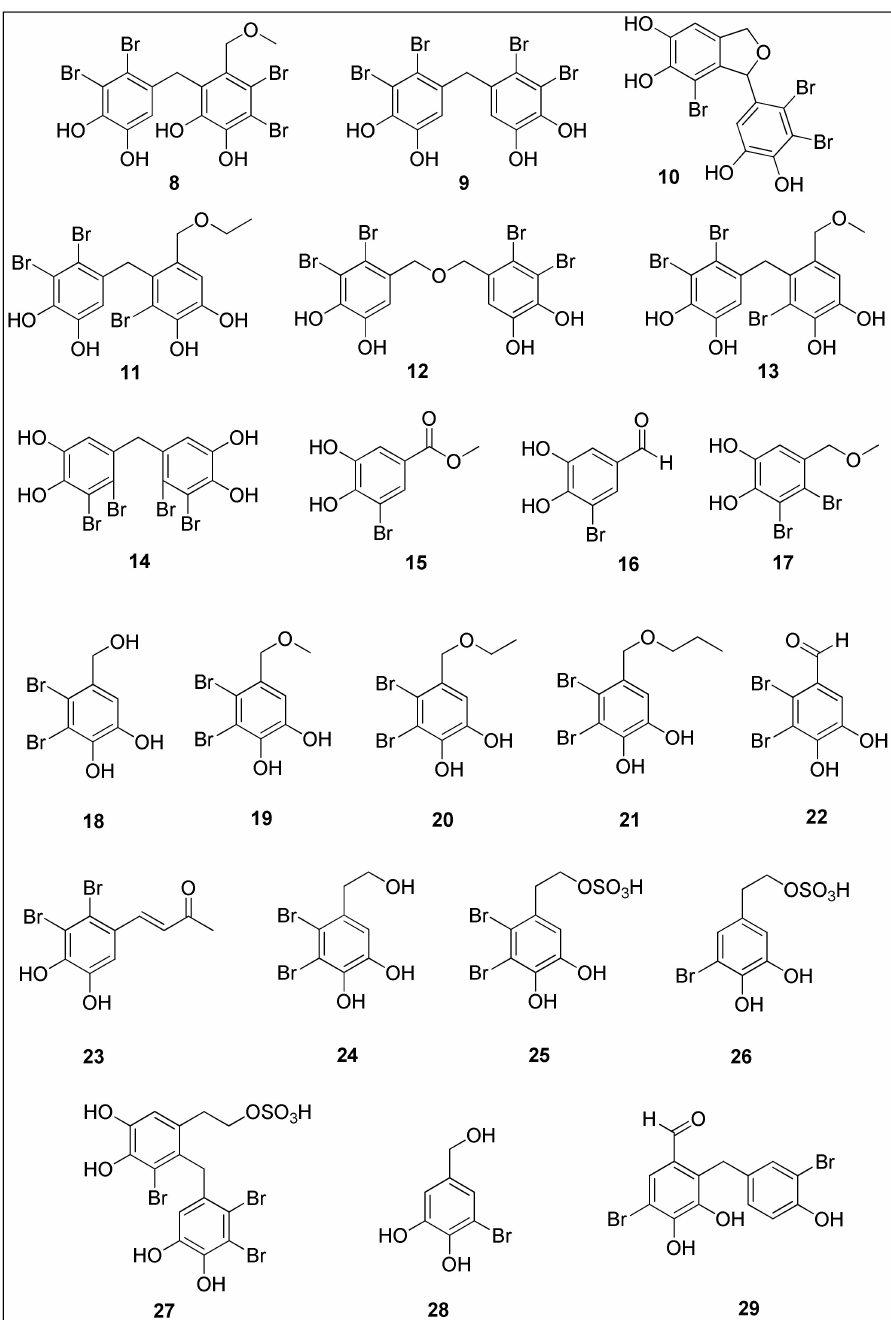
Figure 2. Chemical structures of bromophenols 8 – 29 with significant anticancer activities isolated from brown, red and green